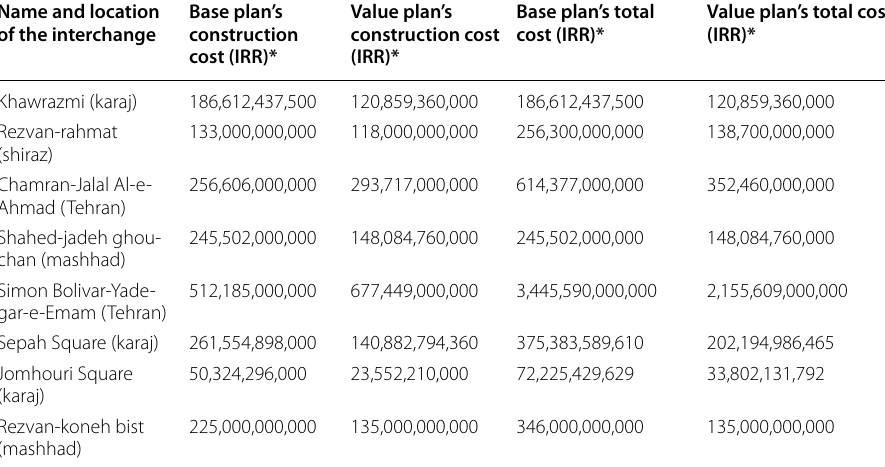
*In the year of the research (2017), each Iranian rial (IRR) was equal to $0.00003